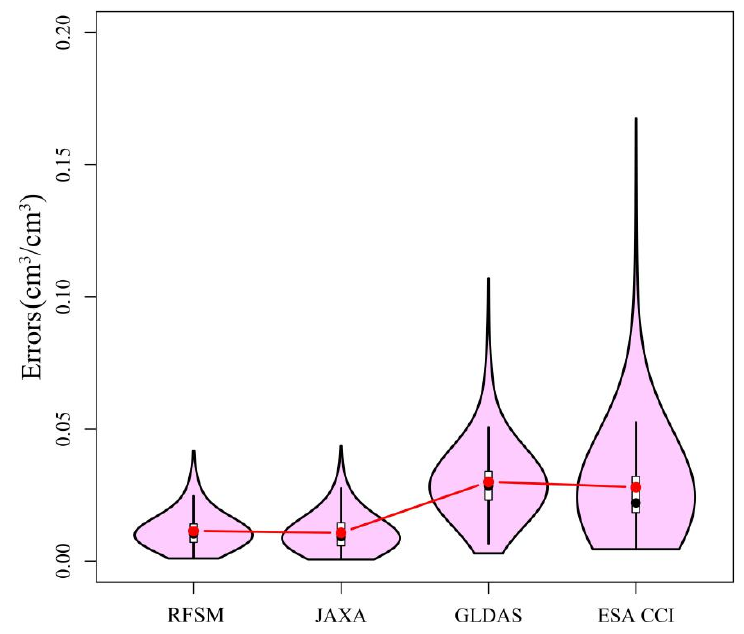
Figure 8. Errors and relative uncertainties calculated by the three-cornered hat (TCH) method from 2010 to 2015: ( a ) RFSM relative errors; ( b ) JAXA relative errors; ( c ) GLDAS relative errors; ( d ) ESA CCI relative errors; ( e ) relative error performance map of the four products, in which the lowest relative errors are shown on the map; ( f ) relative uncertainty performance map of the four products, in which the lowest relative uncertainties are shown on the map.